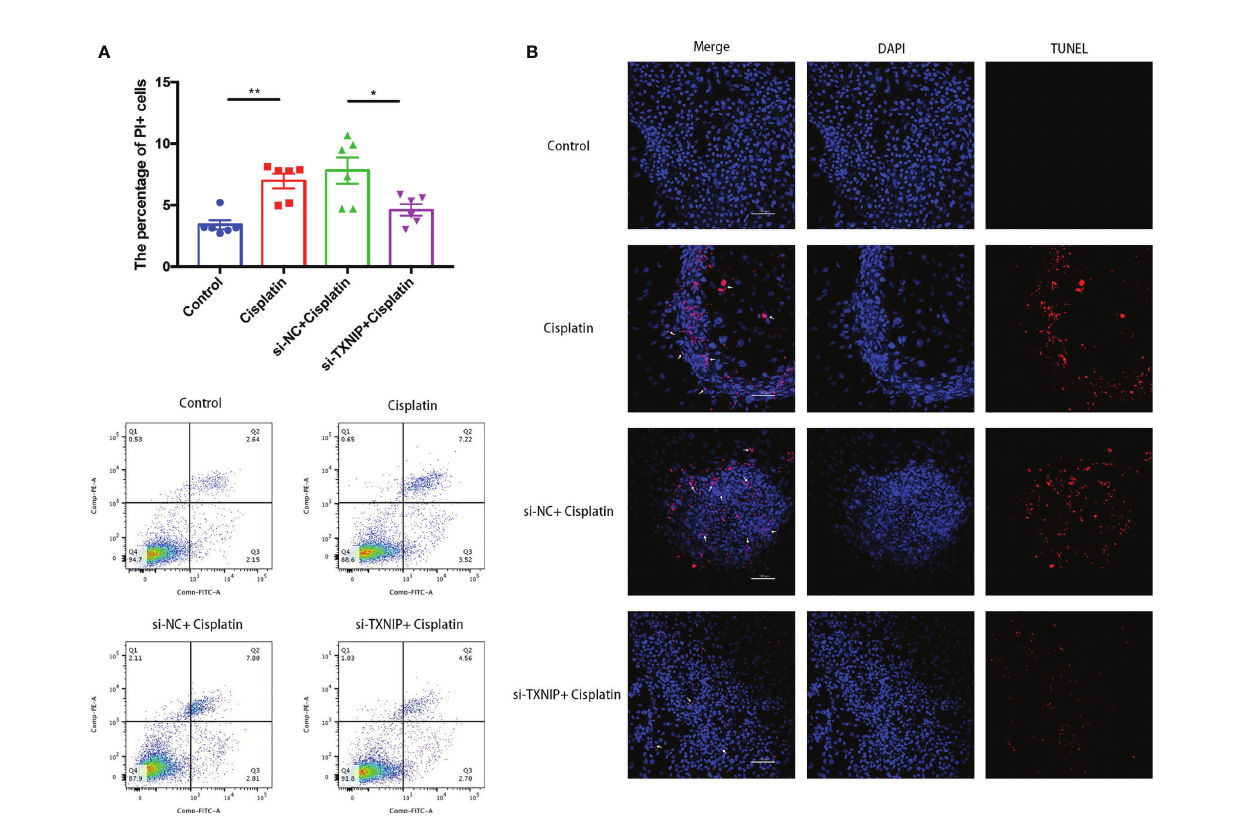
FIGURE 8 | Downregulation of TXNIP decreased the number of MCs with cell membrane rupture (A) or DNA rupture (B) . (A) The differences in the percentage of MCs with cell membrane rupture (the cells in the Q1 and Q2 quadrants) between the groups. (B) The differences in the percentage of MCs with DNA fracture (TUNEL positive) between the groups. Blue fl uorescence indicates DAPI-labeled cell nuclei, and red fl uorescence indicates DNA fragmentation labeled with Alexa Fluor 640. The red fl uorescence overlapping with the nucleus was judged to be TUNEL-positive cells (white arrows). Scale bars: 100 µm. Representative results of at least three repeated experiments are shown. *p < 0.05, **p <